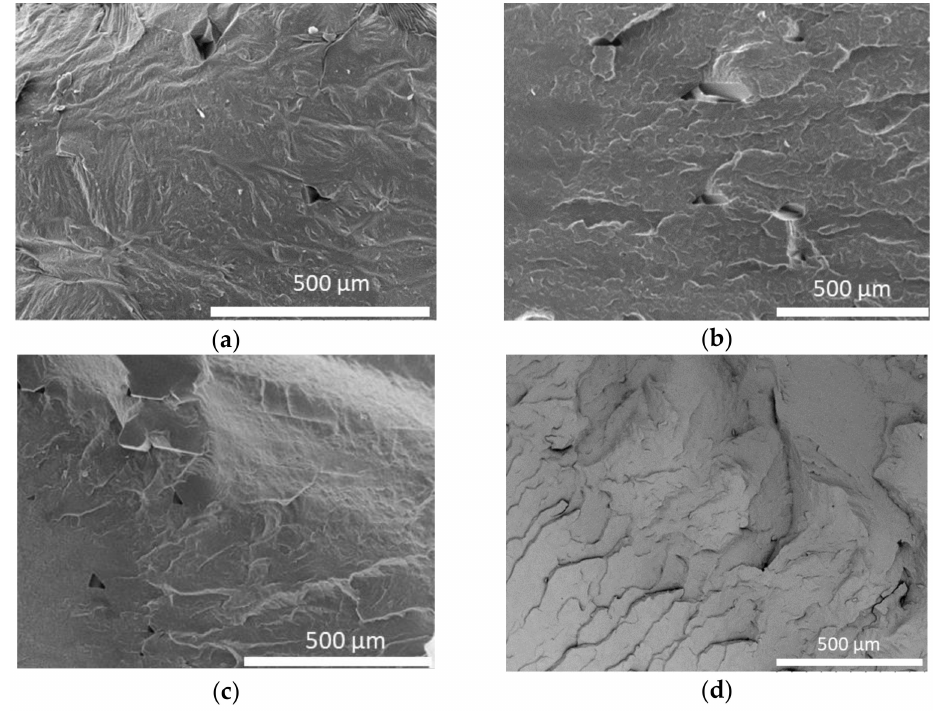
Figure 10. Micrograph of the cross-section of printed filaments obtained employing L22 ( a ), M22 ( b ), M12 [90 ◦ , 90 ◦ ] ( c ), and compression molding ( d